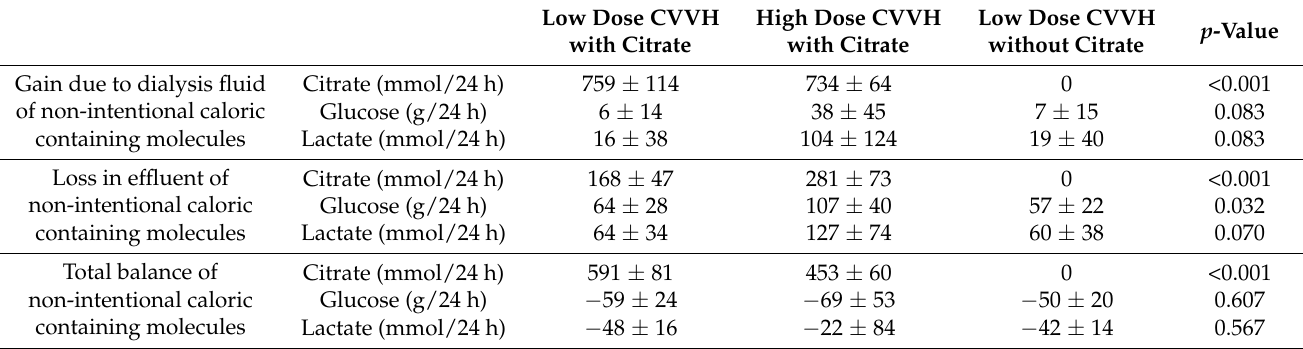
Table 4. Exchange of non-intentional calories during the different Continuous venovenous hemofil- tration (CVVH)